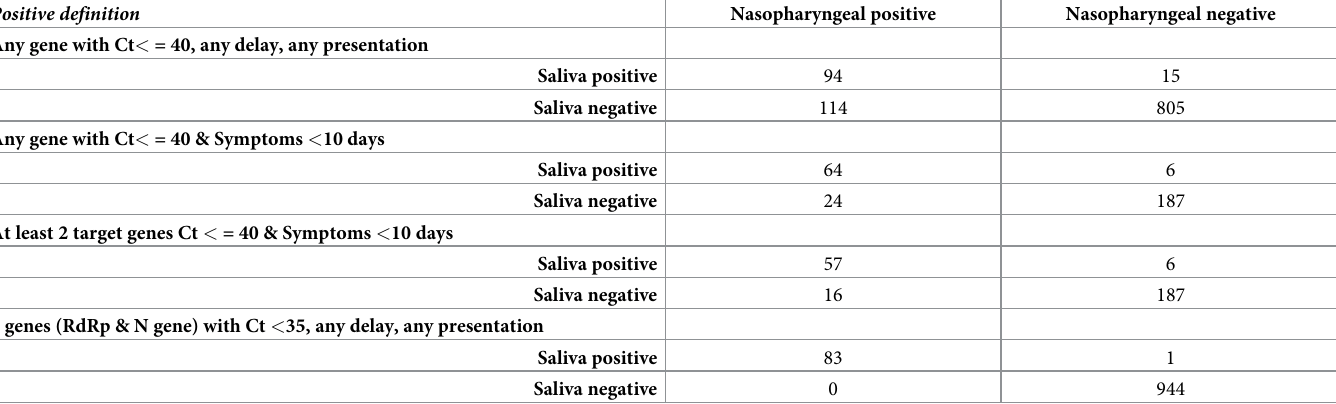
Table 1. RT-PCR positive results for nasopharyngeal and saliva samples for different definitions of positivity.